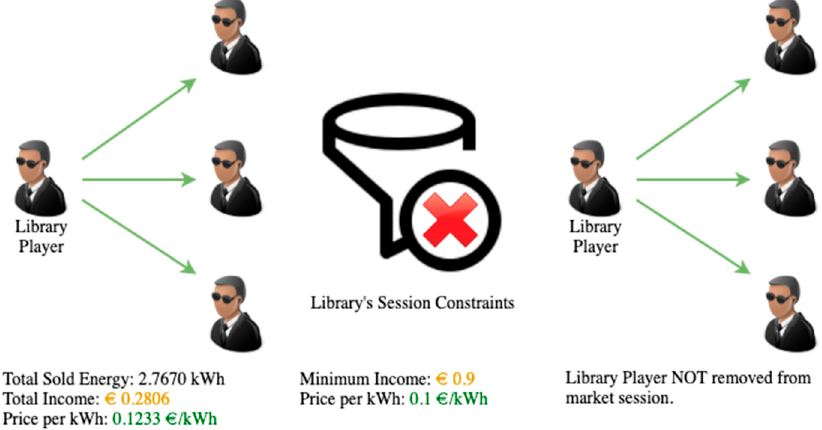
Figure 5. Library player session results after applying session constraints.